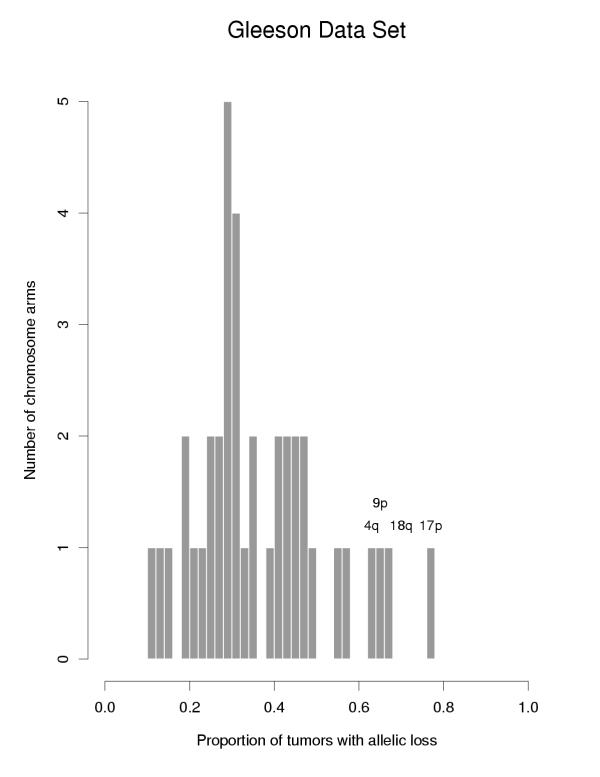
Histogram of allelic loss for the Gleeson data set